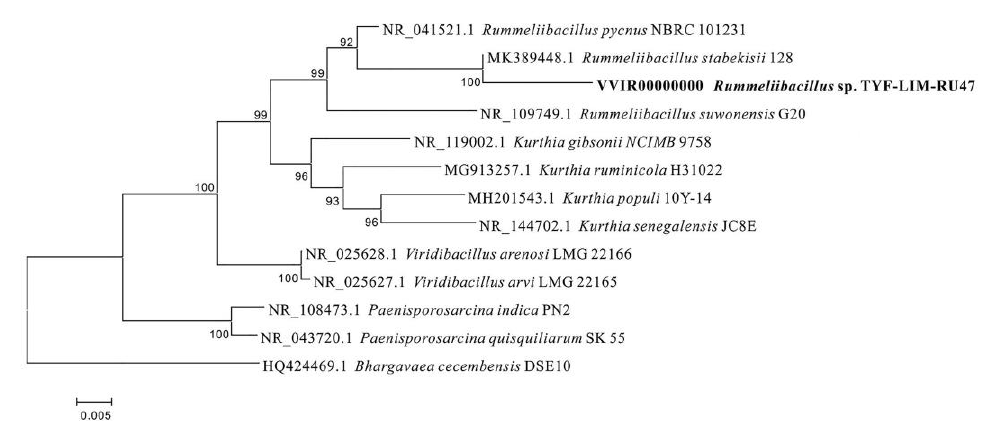
Figure 1. Phylogenetic tree of Rummeliibacillus sp. TYF-LIM-RU47 based on its 16S rRNA gene sequences.